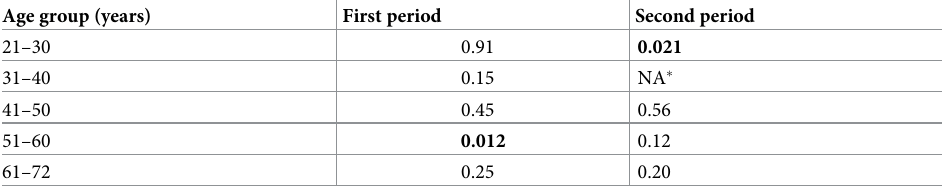
Table 6. Contrast pairwise comparison of mean anti-S-RBD IgG antibody titers (provided in S2 Table) of genders of study participants (males vs . females) by age within each sampling